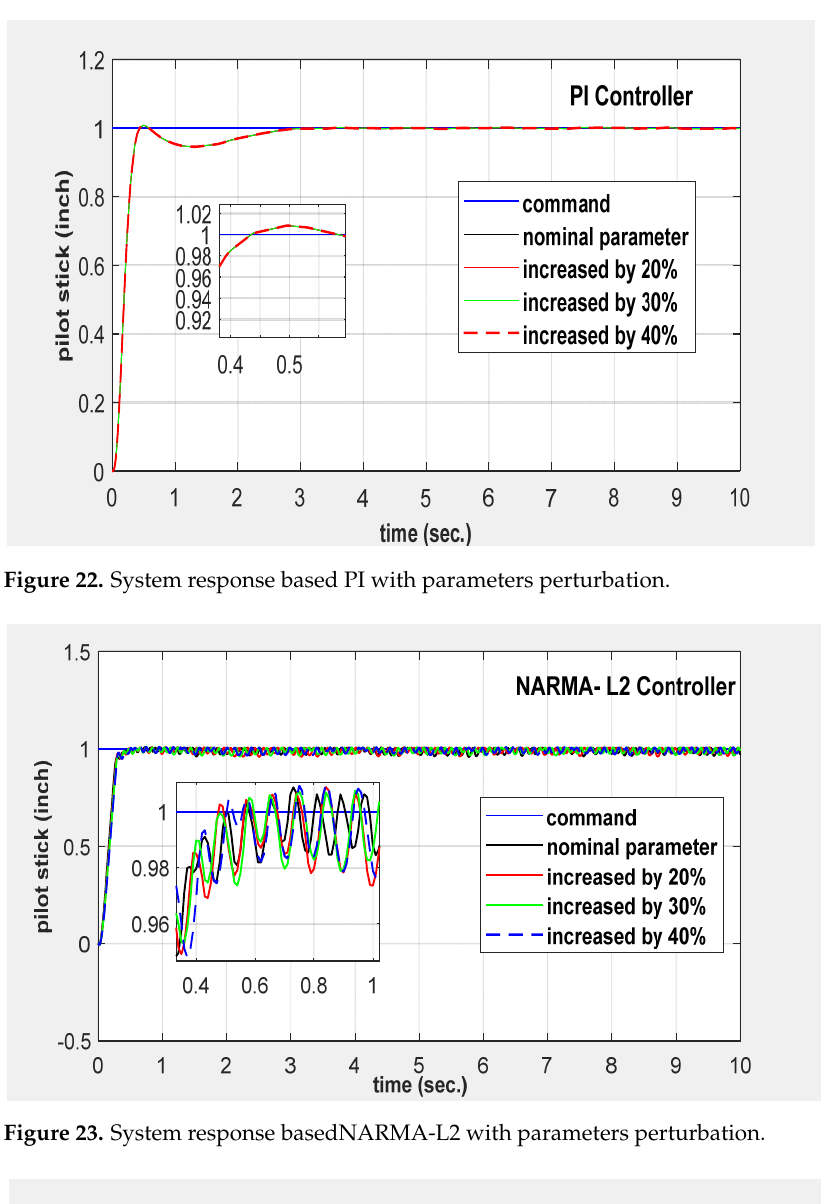
Figure 21. Chart of performance criteria in system perturbation by 40%.